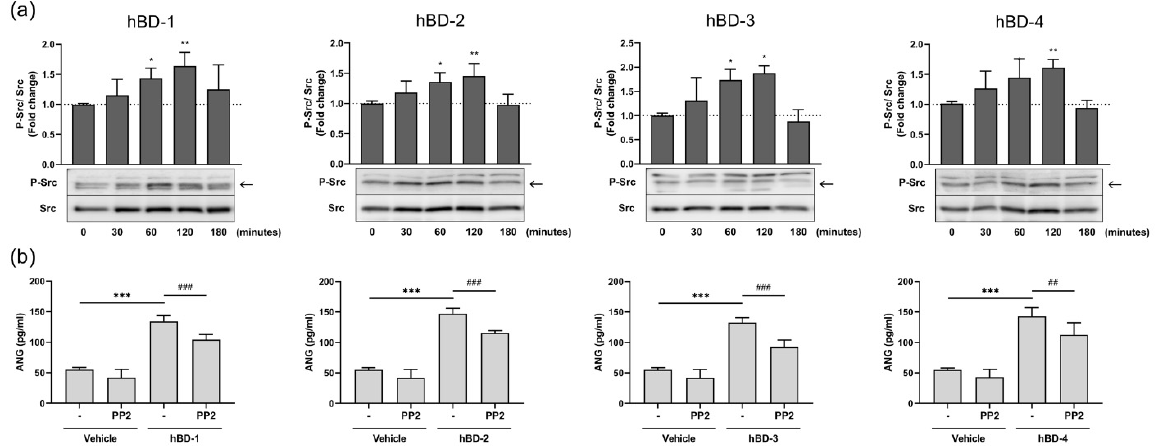
Figure 4. hBDs induce ANG production by activating the Src pathway. ( a ) Human dermal fibroblasts were stimulated with 20 μ g/mL hBD-1, 20 μ g/mL hBD-2, 10 μ g/mL hBD-3, or 20 μ g/mL hBD-4 for 30–120 min, and the levels of phosphorylated and unphosphorylated Src in whole cell lysates were analyzed by Western blotting. * p < 0.05 and ** p < 0.01 compared between the unstimulated (0 min) and the hBD-stimulated groups by one-way ANOVA with Tukey’s multiple comparisons test. ( b ) Fibroblasts were preincubated with 20 μ M PP2 (Src inhibitor) or solvent (-) for 2 h. Cells were then stimulated for 6 h with 20 μ g/mL hBD-1, 20 μ g/mL hBD-2, 10 μ g/mL hBD-3, or 20 μ g/mL hBD- 4. The concentrations of ANG in cell-free supernatants were determined by ELISA. *** p < 0.001 compared between the presence and absence of hBDs without inhibitors; ## p < 0.01 and ### p < 0.001 compared between the inhibitor-treated and untreated groups with hBD stimulation using one-way ANOVA with Tukey’s multiple comparisons test. All results are the means ± SDs of 3–6 independent experiments. 2.3. hBD-Mediated ANG Production Requires the Activation of the Mitogen-Activated Protein Kinase (MAPK) and Nuclear Factor-Kappa B (NF- κ B) Pathways The MAPK pathways play key roles in many biological activities, including cell sur- vival and metabolism, and have been reported to be activated by hBDs in keratinocytes and mast cells [23–25]. To evaluate whether hBDs could also activate MAPKs in fibro- blasts, cells were incubated with hBD-1, hBD-2, hBD-3, and hBD-4 for 5–60 min, and the phosphorylation of MAPK p38, JNK, and extracellular signal-regulated kinase (ERK) 1/2 was examined using Western blotting. hBD-1, hBD-2, hBD-3, and hBD-4 increased the phosphorylation of p38 at 5 min, and this phosphorylation was still remarkable at 60 min after stimulation with hBD-1 and hBD-3. All hBDs also enhanced JNK and ERK1/2 phos- phorylation, which peaked at 5 min, before decreasing (Figure 5a). The requirement for MAPK pathways in hBD-mediated ANG production was evaluated by treating fibroblasts with MAPK inhibitors for 2 h, before stimulation with hBDs. SB203580 (p38 inhibitor) and JNK inhibitor II markedly decreased hBD-mediated ANG production, while U0126 (ERK inhibitor) had no effect on ANG secretion (Figure 5b). The failure of U0126 to inhibit hBD- induced ANG production by fibroblasts was not due to the inactivity of this inhibitor, because treatment of fibroblasts with U0126 completely suppressed both hBD-induced and spontaneous ERK phosphorylation. Other inhibitors, SB203580 and JNK inhibitor II, also abolished p38 and JNK phosphorylation (Supplementary Figure S4).